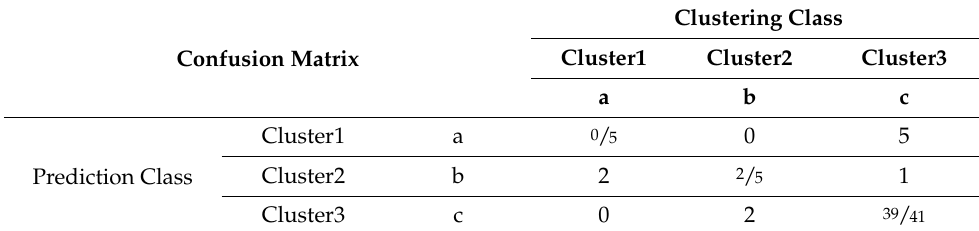
Table 12. Neural network classification validation for K-means clustering.